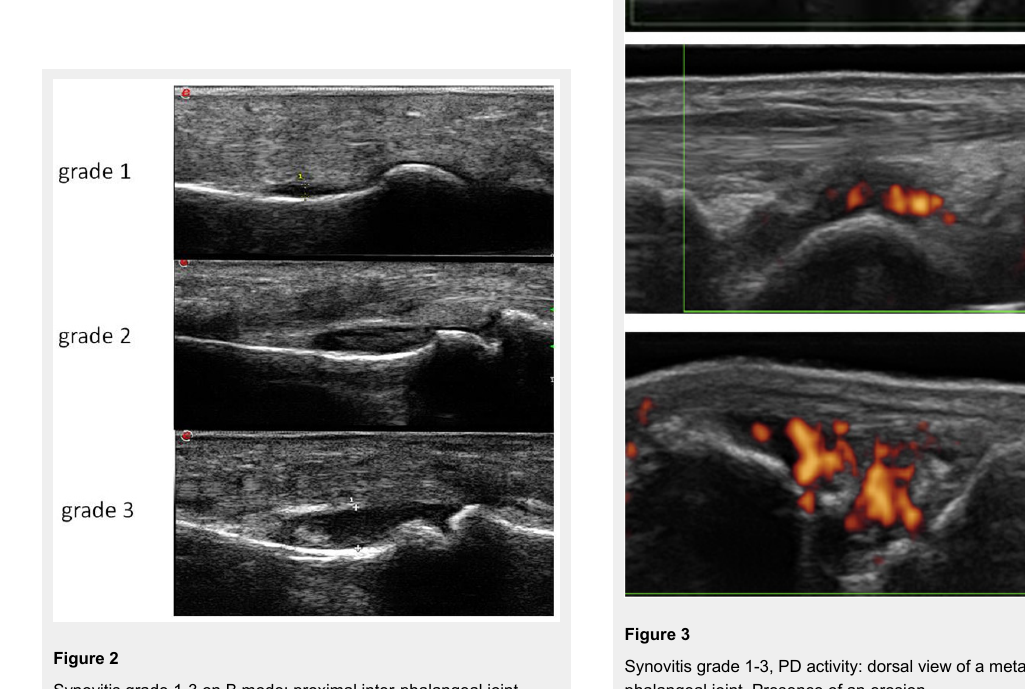
Synovitis grade 1-3 on B mode: proximal inter-phalangeal joint.